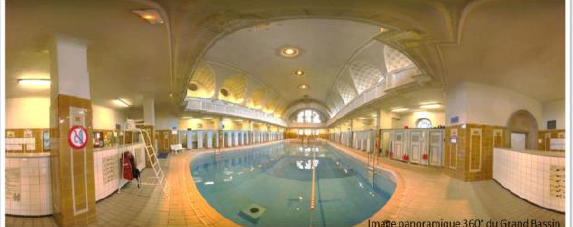
Figure 6 : Panoramic image of the big pool seen from the beach on the north side